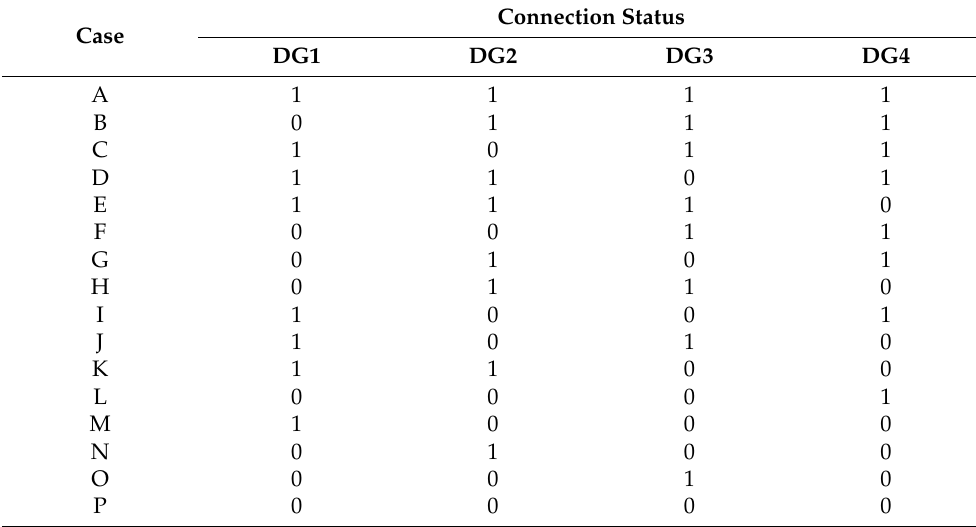
Table 2. Case studies involving topology changes.